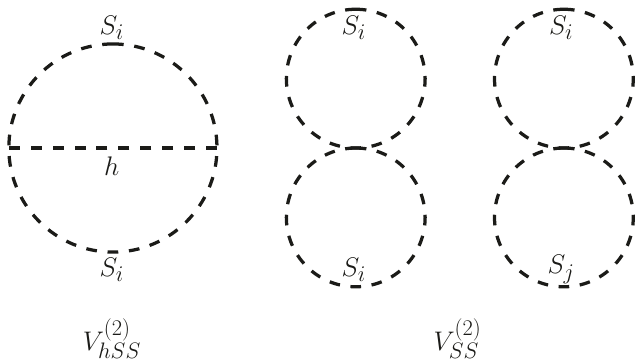
Figure 2 . Leading two-loop BSM diagrams contributing to the effective potential of the O ( N ) - symmetric CSI model — in addition to the leading SM diagrams of figure